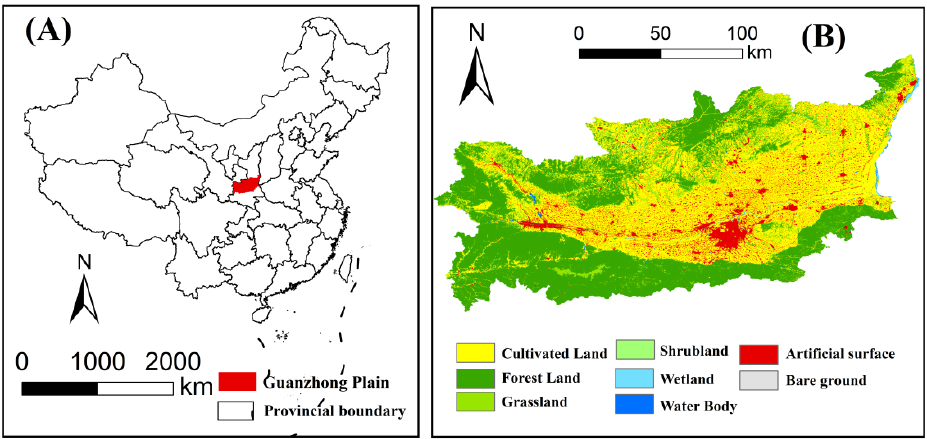
Figure 1. The location of the Guanzhong Plain ( A ) and the status of land use in 2020 ( B ).